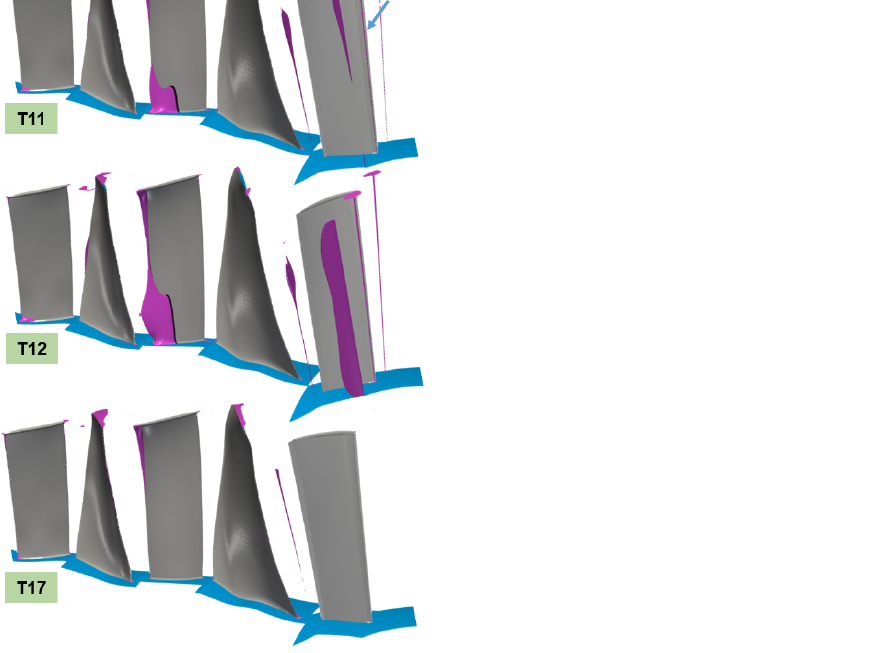
Figure 8. View of IGV with the first two stages, recirculating flow regions highlighted by iso-surface of zero axial velocity.